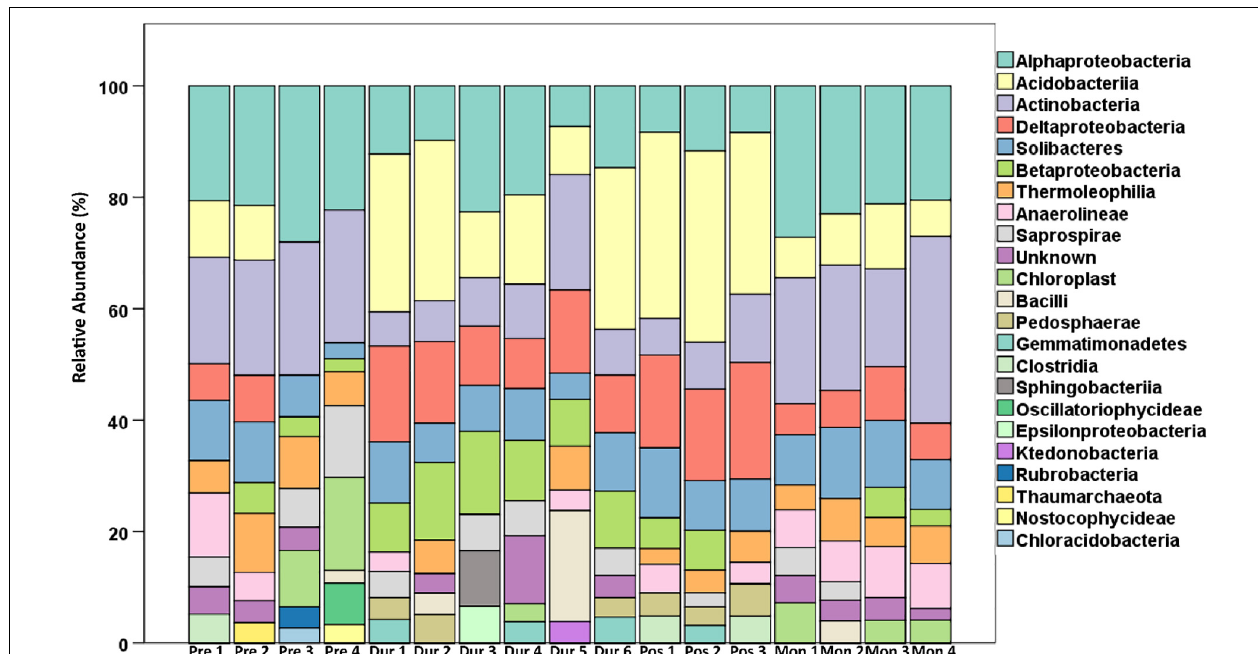
FIGURE 4 | Microbial community composition of the top 10 most abundant classes within each sample. Two soil samples were taken within the Aquatic Zone across day and night sampling for each environmental phase ( n = 4 per phase). At the Pre and 1 Month phases (Pre 1–4 and Mon 1–4), there was no water in the wetland, whereas at the During and Post phases (Dur 1–6 and Pos 1–3), soils were inundated. More samples were taken in the During phase ( n = 6), as the presence of CH 4 emissions was detected during this phase. Therefore, extra sampling ensured that bacteria producing CH 4 were captured for this experiment. One sample in the Post phase was unable to be sequenced ( n = 3).